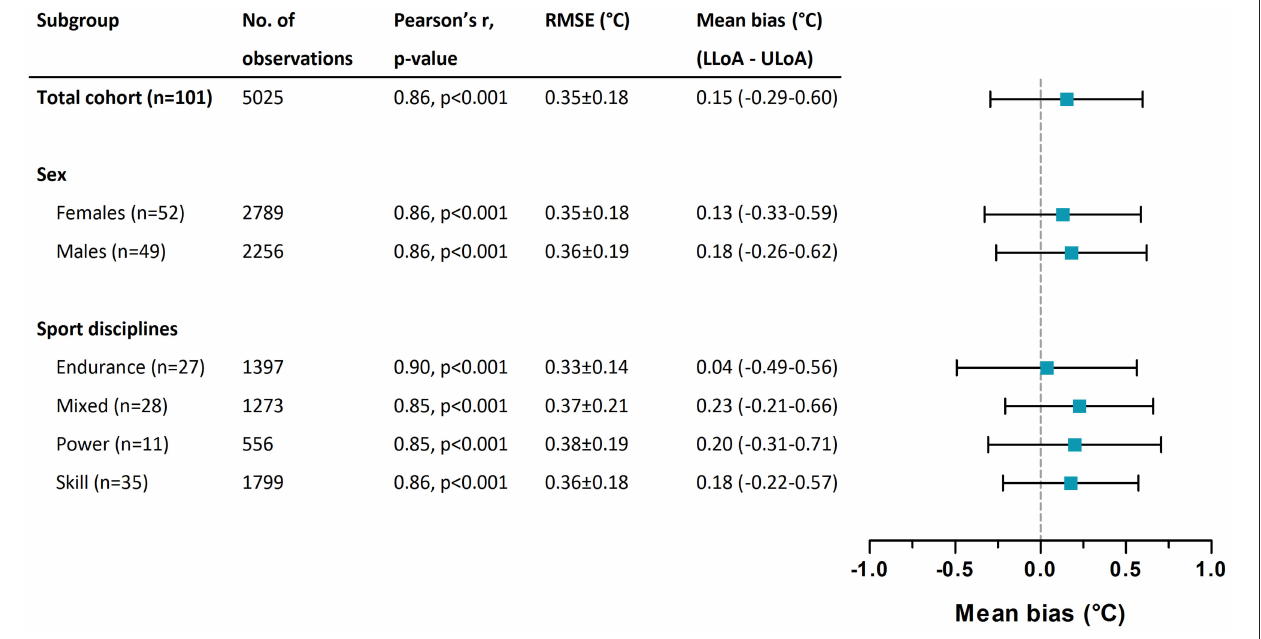
FIGURE 4 | Subgroup-specific Pearson correlation coefficients between T c − est and T c , root mean square errors (RMSE) weighted for participant and exercise test duration across T c − est and T c , and the mean bias for T c − est . Mean bias is presented with the lower limit of agreement (LLoA) and the upper limit of agreement (ULoA).